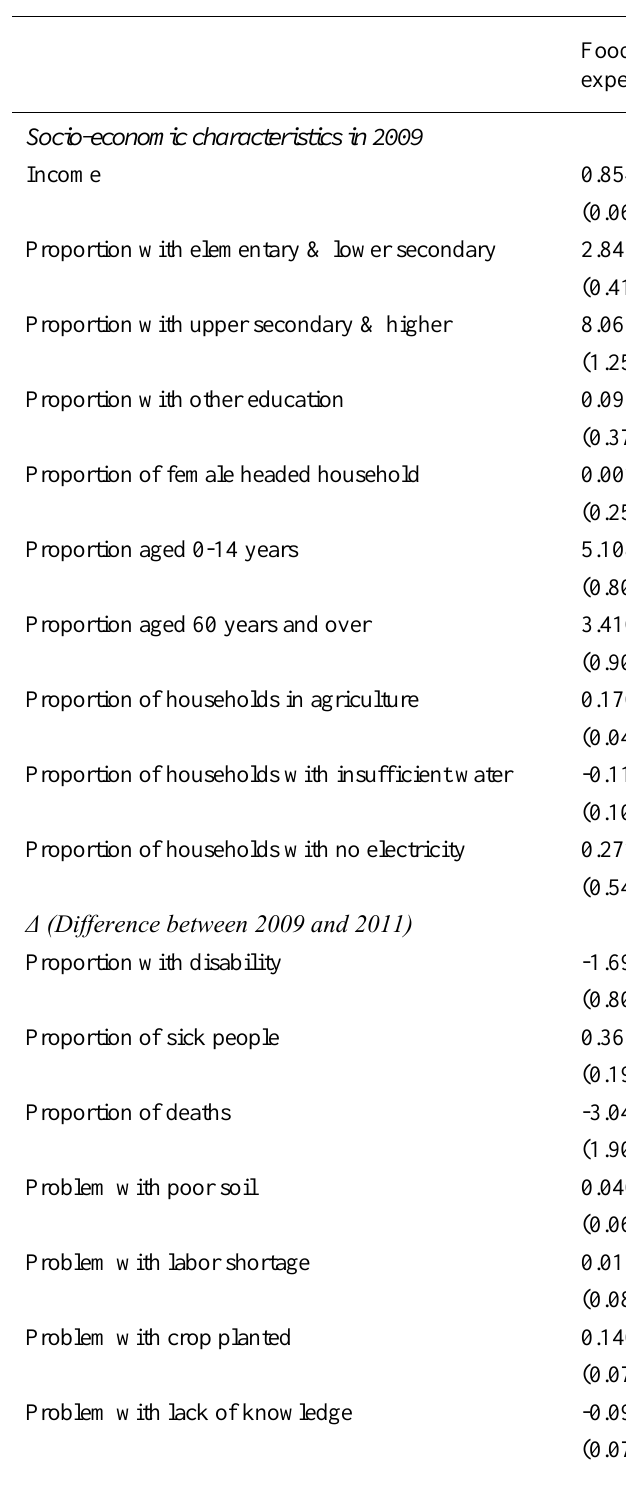
Table A1.1. Difference-in-difference estimates of community welfare (standard errors in parentheses): low education